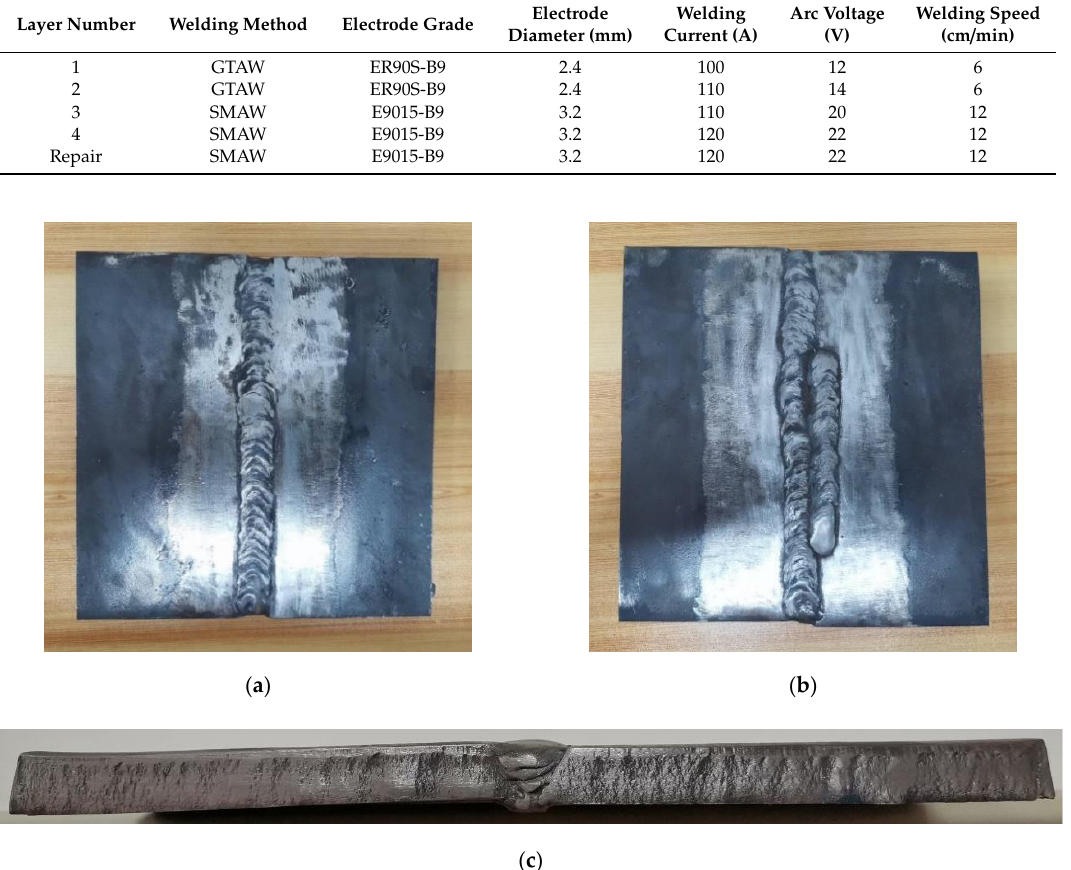
Figure 12. Morphology of specimens: ( a ) after initial welding; ( b ) after repair welding; ( c ) morphology of welding